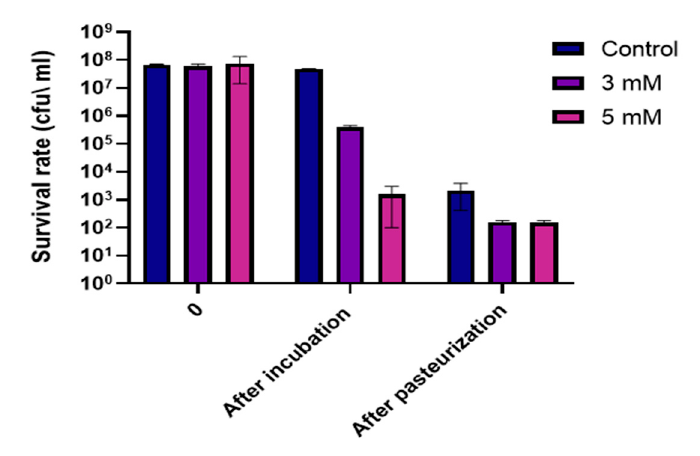
Figure 5. Exposure to Zn 2 + ions decreases resistance of B. cereus cells to heat treatment. B. cereus cells incubated with 3 mM and 5 mM ZnCl 2 were subjected to heat treatment performed at 72 ◦ C for 30 s. Survival rate was determined using the CFU method. * p -value < 0.05 comparing with control. Error bars represent standard deviation (SD).